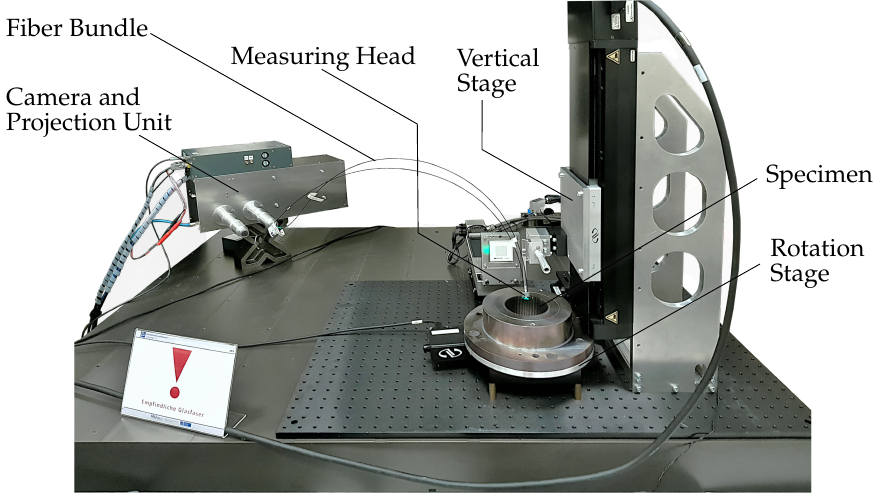
Figure 5. Experimental setup with major